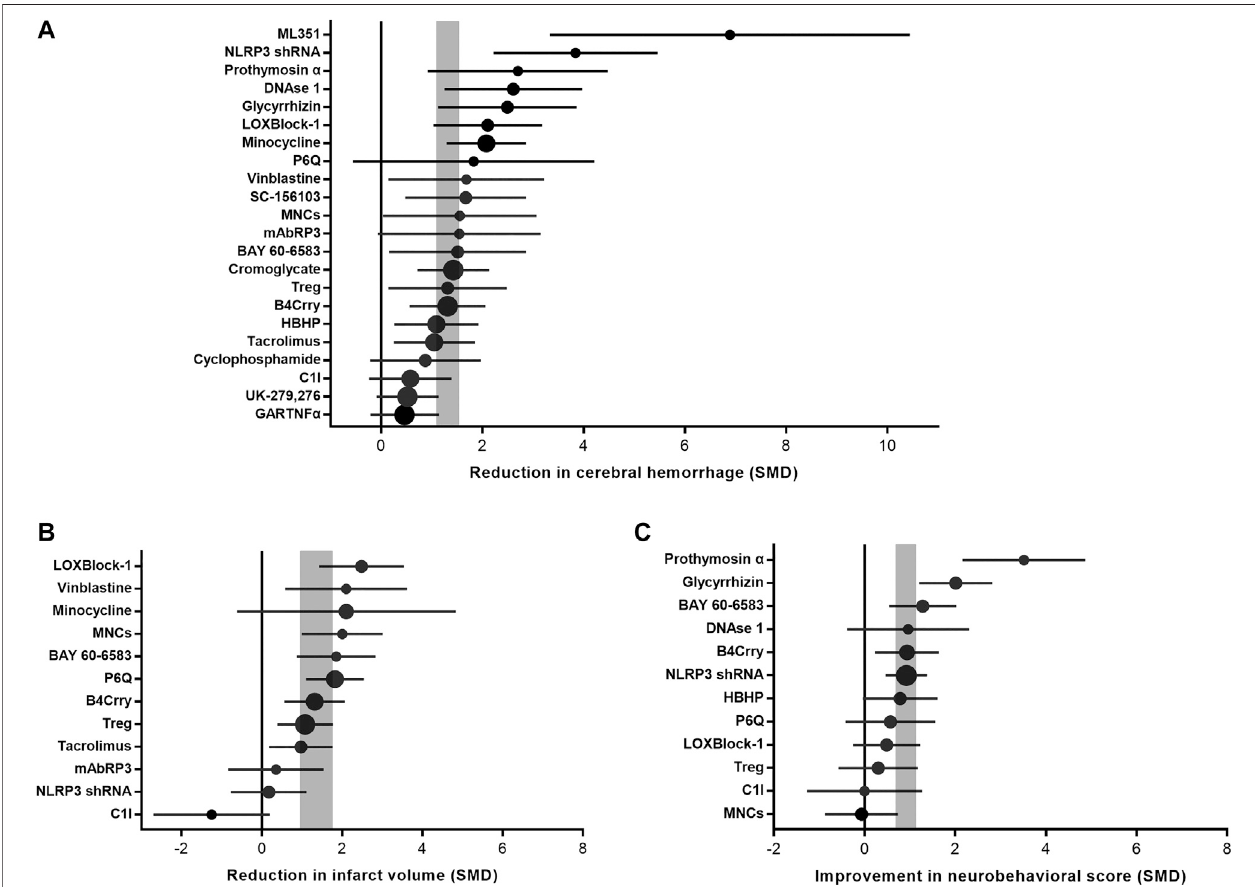
FIGURE 3 | Ef fi cacy of immunomodulators on intracerebral hemorrhage, infarct size, and neurobehavioral score. Forest plots of the effect size in intracerebral hemorrhage (A) , infarct size (B) , and neurobehavioral score (C) calculated using standardized mean differences. Symbol sizes represent the relative number of animals tested for each intervention. The horizontal error bars represent the 95% con fi dence interval of individual studies. The vertical gray bars represent the 95% con fi dence interval of the pooled estimate of ef fi cacy.